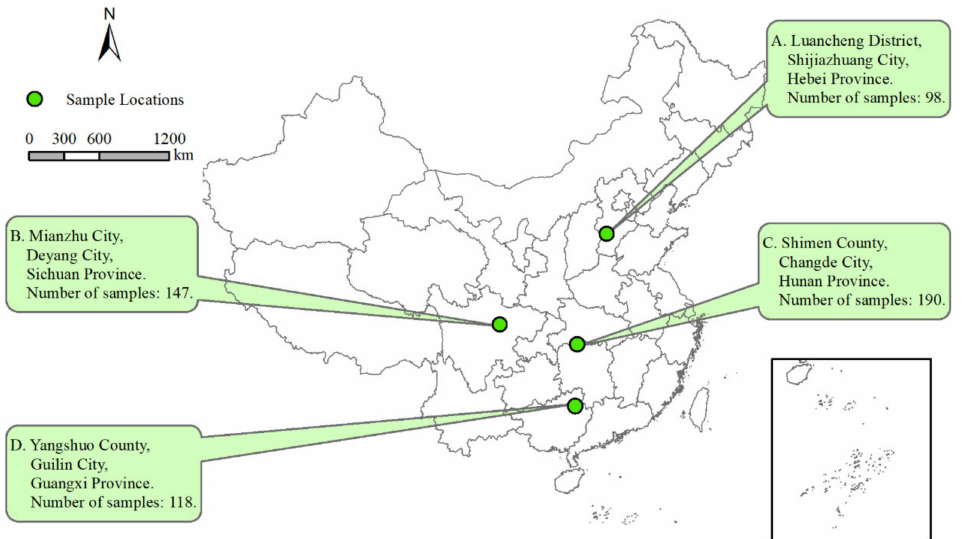
Figure 2. Details of the considered study